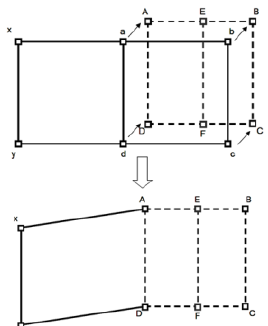
Figure 2 :. Cadastral Boundaries (Solid Lines) and Higher Accuracy (Dashed Lines). Polygon xady is Distorted If